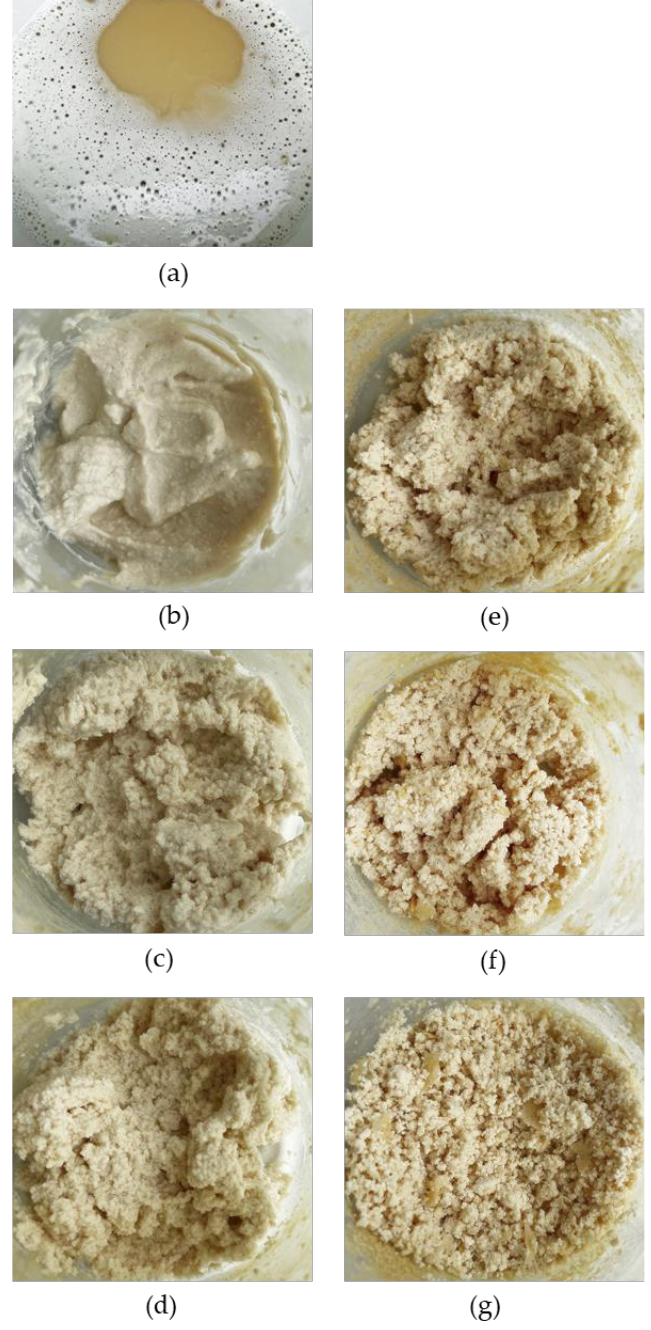
Figure 2. Polymerized whey protein depending on heating time. ( a ): 0 min time of heat treatment; ( b – d ): single-heated polymerized whey protein after 10, 20, or 30 min heat treatment, respectively; ( e – g ): double-heated polymerized whey protein after 10, 20, or 30 min heat treatment, respectively.